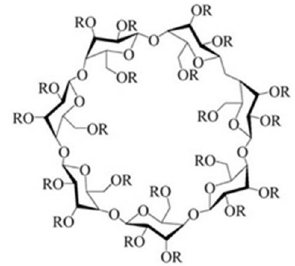
Figure 2. Chemical structure of hydroxypropyl β -cyclodextrin and sulfobutyl ether β -cyclodextrin, adapted from [17]. HP-β-CD: R = -CH 2 CHOHCH 3 ; SBE-β-CD: R = -(CH 2 ) 4 SO 3 -Na +